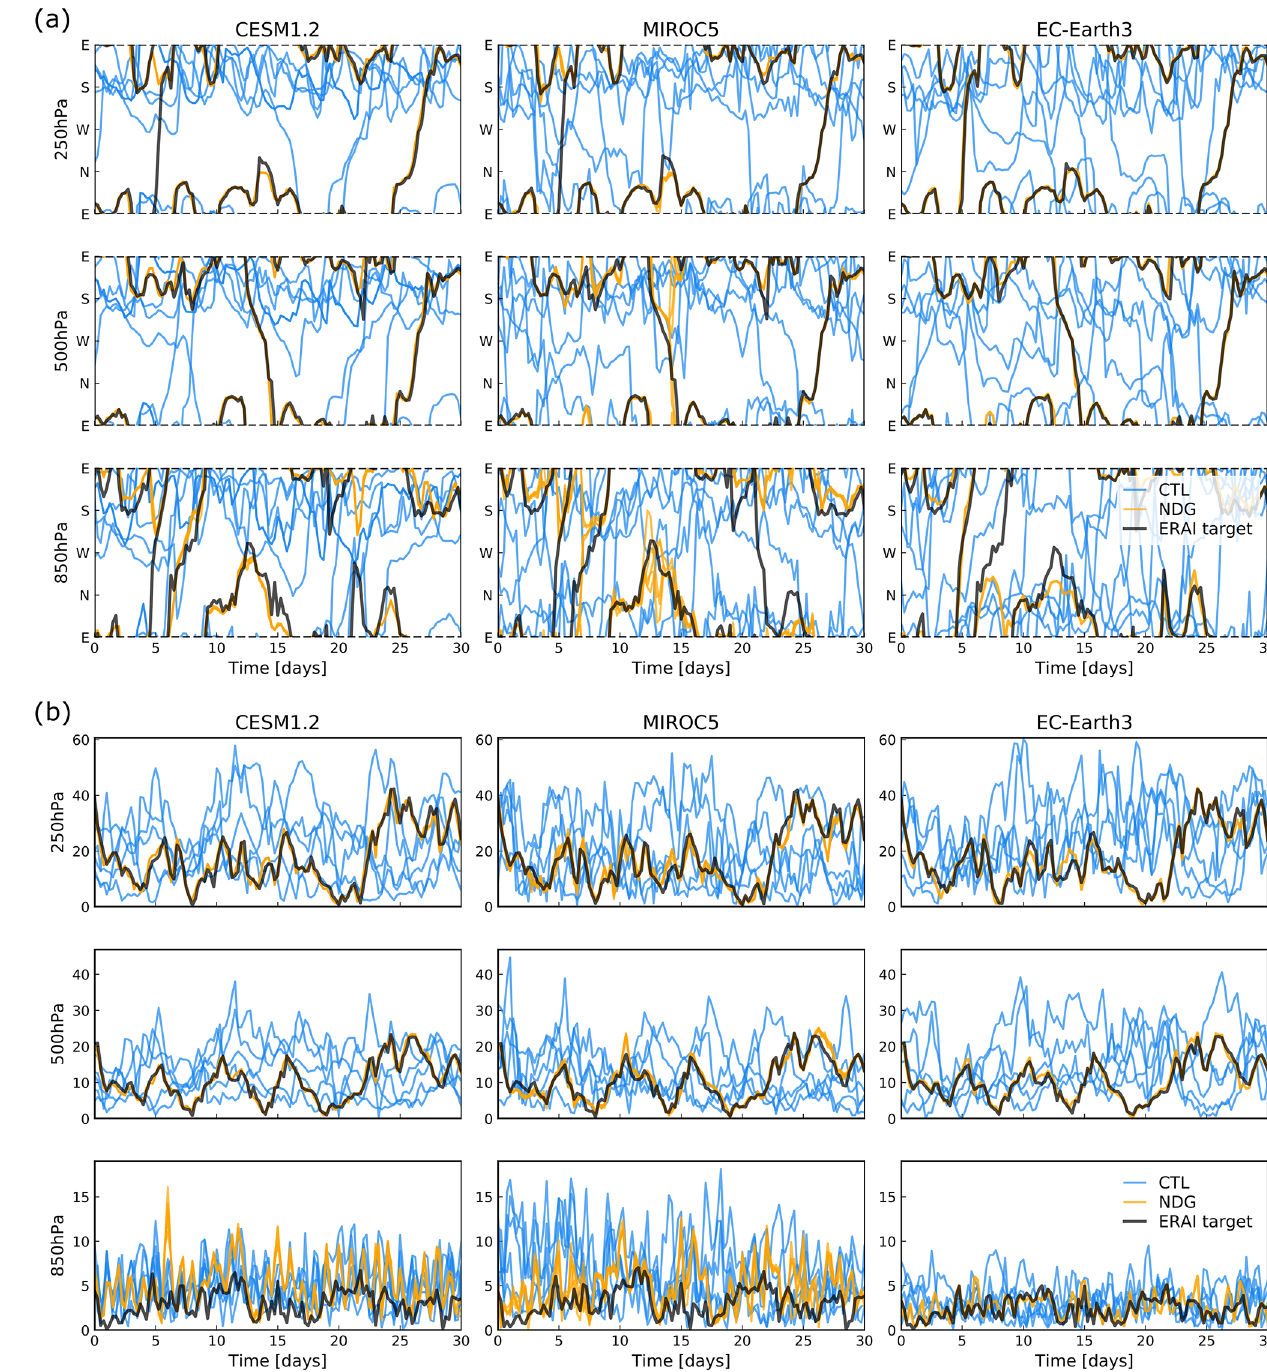
Figure A1. Comparison of winds for the experiments with a nudged atmosphere (NDG, corresponds to AF_SI) and free atmosphere (CTL, corresponds to AI_SI). Shown are 6-hourly wind direction (a) and wind speed (b) during 1 month (June 2000) for one grid point over the Alps. The winds from the models were interpolated to 250, 500, and 850hPa. The winds from ERA-Interim (ERAI target) were interpolated to the same pressure levels and the model resolution for each model.